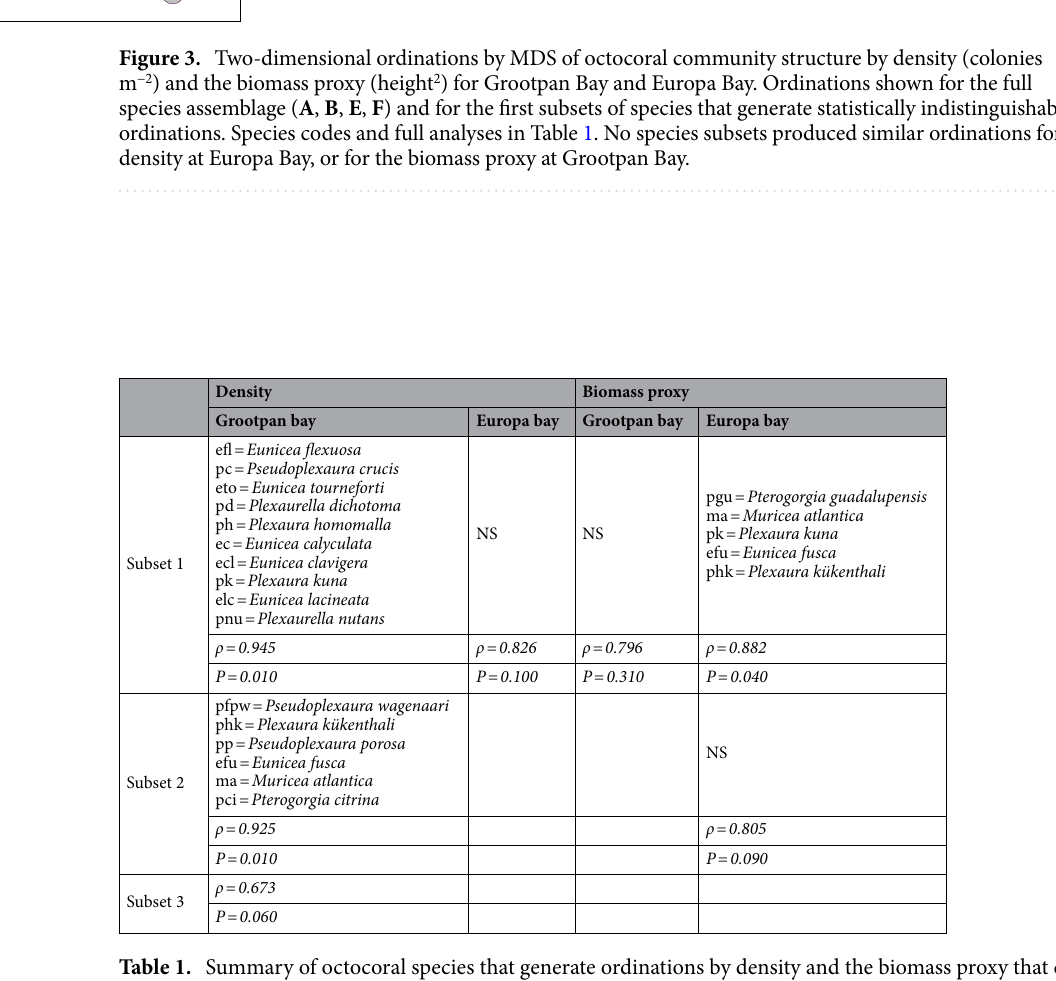
Table 1. Summary of octocoral species that generate ordinations by density and the biomass proxy that do not significantly differ from that produced by all taxa (Fig. 3) for Grootpan Bay and Europa Bay. Taxa were filtered to remove the least common members that together account for < 2% of organisms (on density and biomass